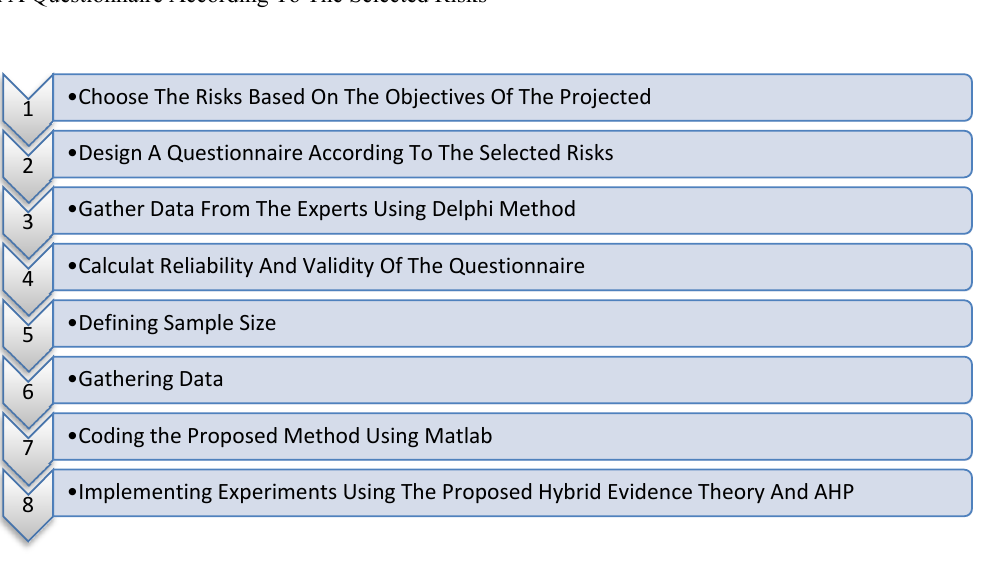
Fig. 2. The process of the risk assessment